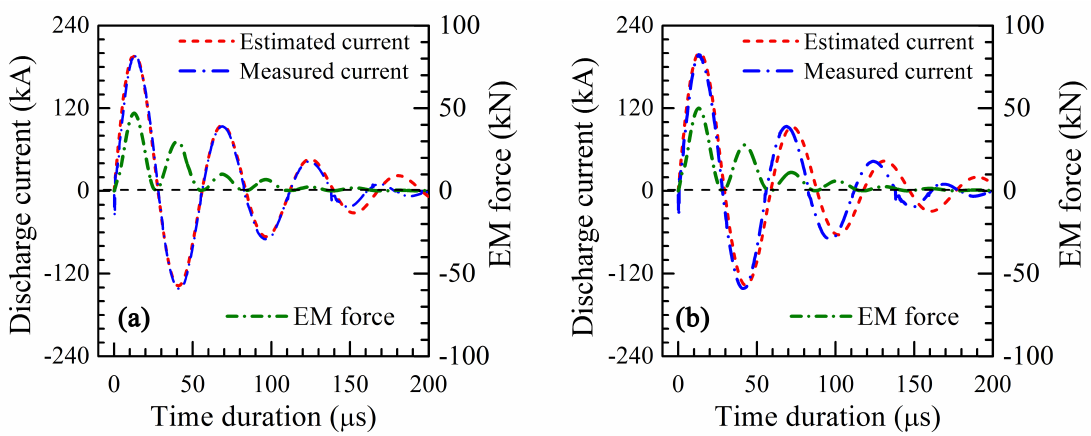
Figure 7. Experimentally measured and analytically estimated nature of the discharge current, and numerically computed EM force for an applied energy of ( a ) 14 kJ and ( b ) 16